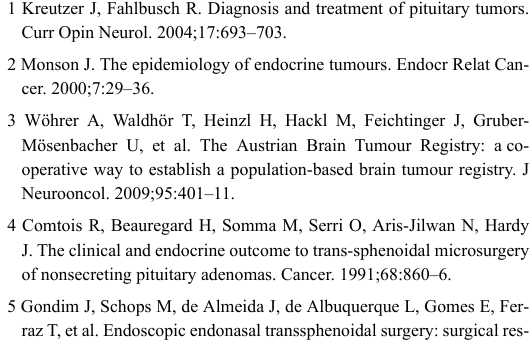
Hypopituitarism Permanent substitutionHardyClass. Patient